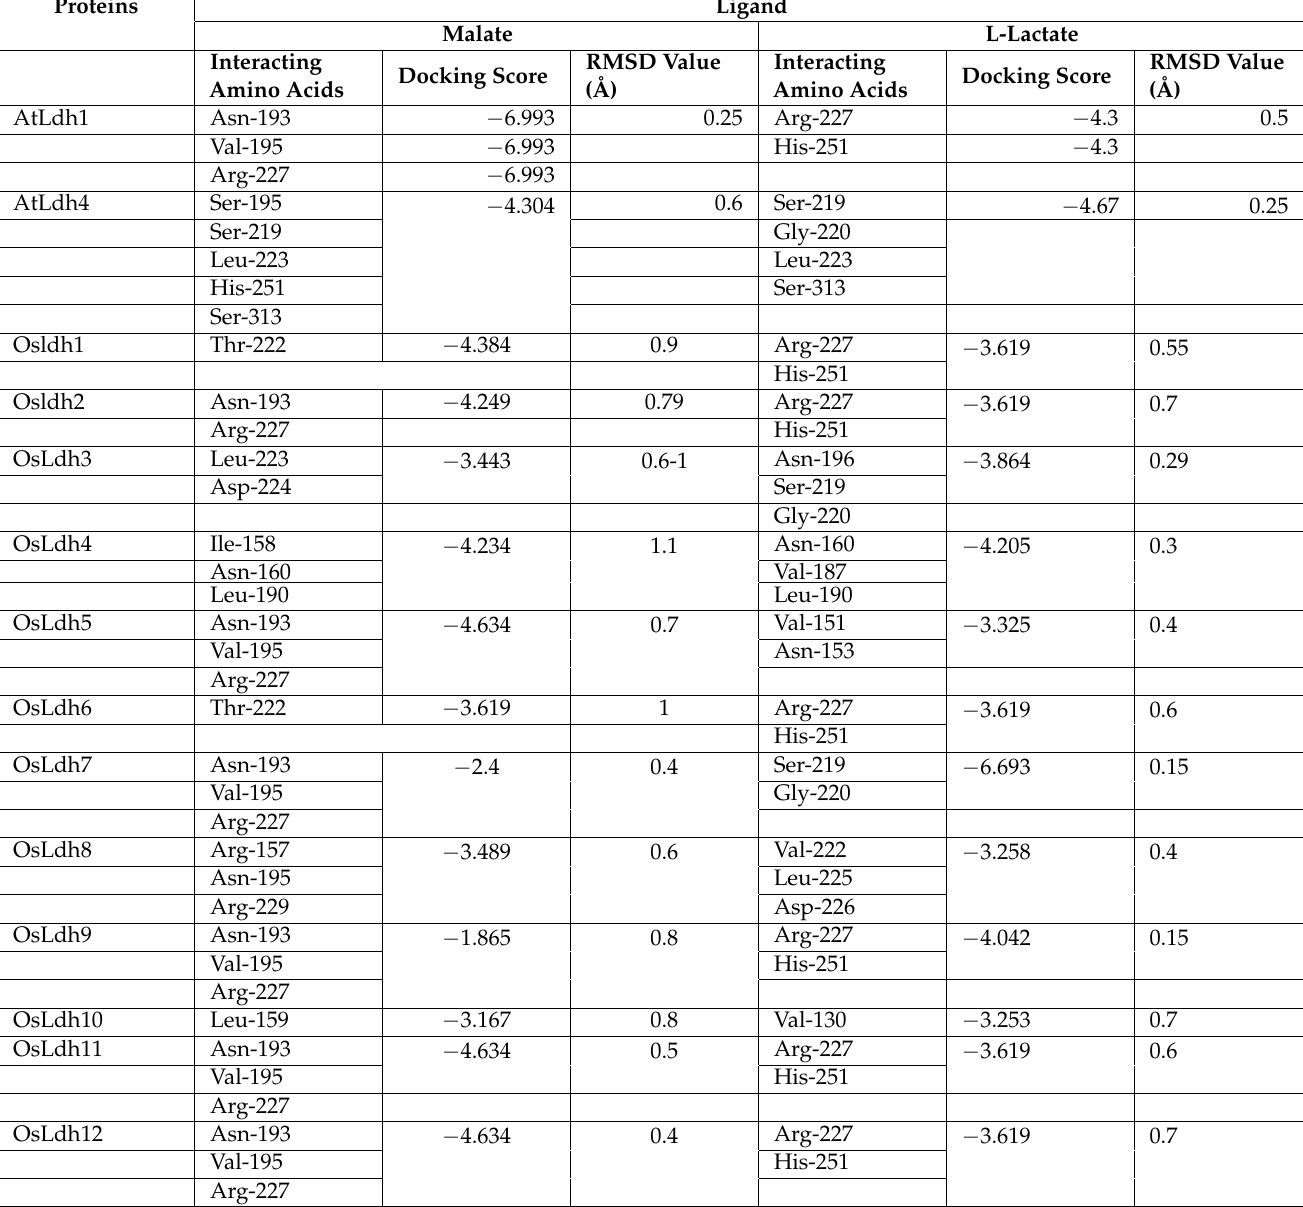
Table 2. The docking score, RMSD value and interacting amino acids of each of the putative Ldh enzymes with malate and L-lactate as ligands are enlisted in the